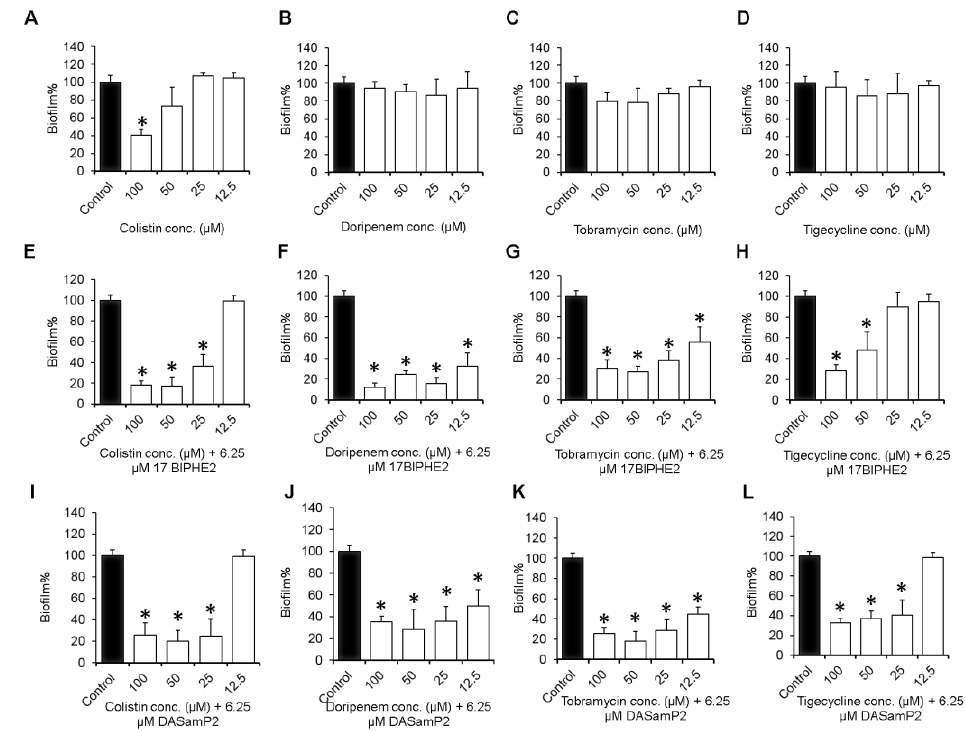
Figure 4. Disruption of the 24 h established biofilms of P. aeruginosa PAO1. Shown are panels A – D representing antibiotics alone, E – H are combination of antibiotics + 17BIPHE2 and I – L are antibiotics + DASamP2, respectively. p values were calculated based on paired Student’s t -test with two tailed distribution and values <0.05 were considered significant (*).